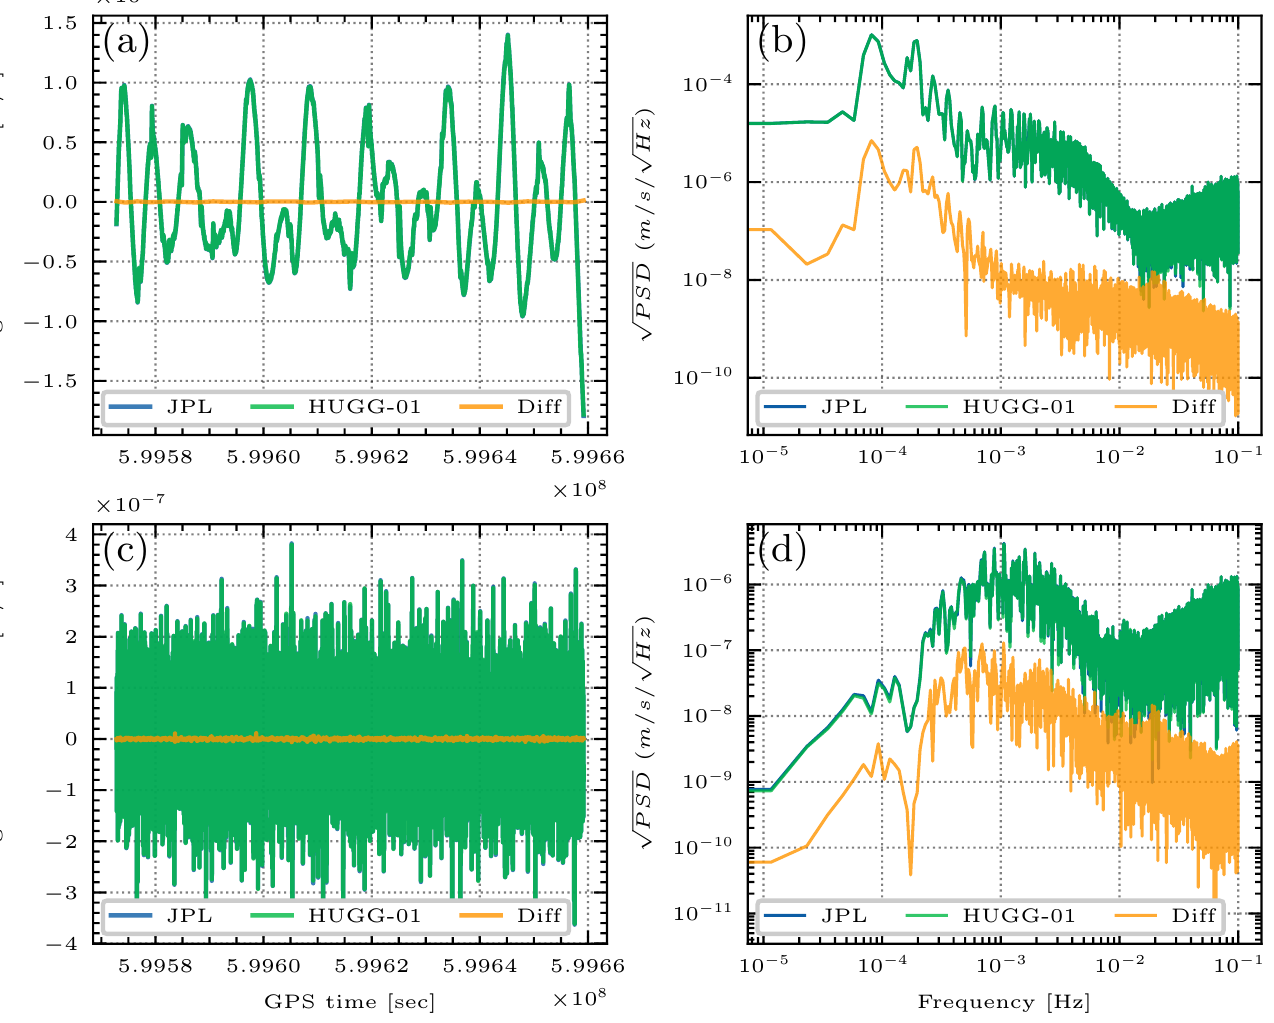
Figure 10. K-band range-rate residuals derived from the JPL (in blue) and HUGG-01 (in green) attitude products on 1 January 2019. Their differences are denoted with the orange curve. ( a , b ) denote the pre-fit residuals, whereas ( c , d ) denote the post-fit residuals after extracting the gravity field